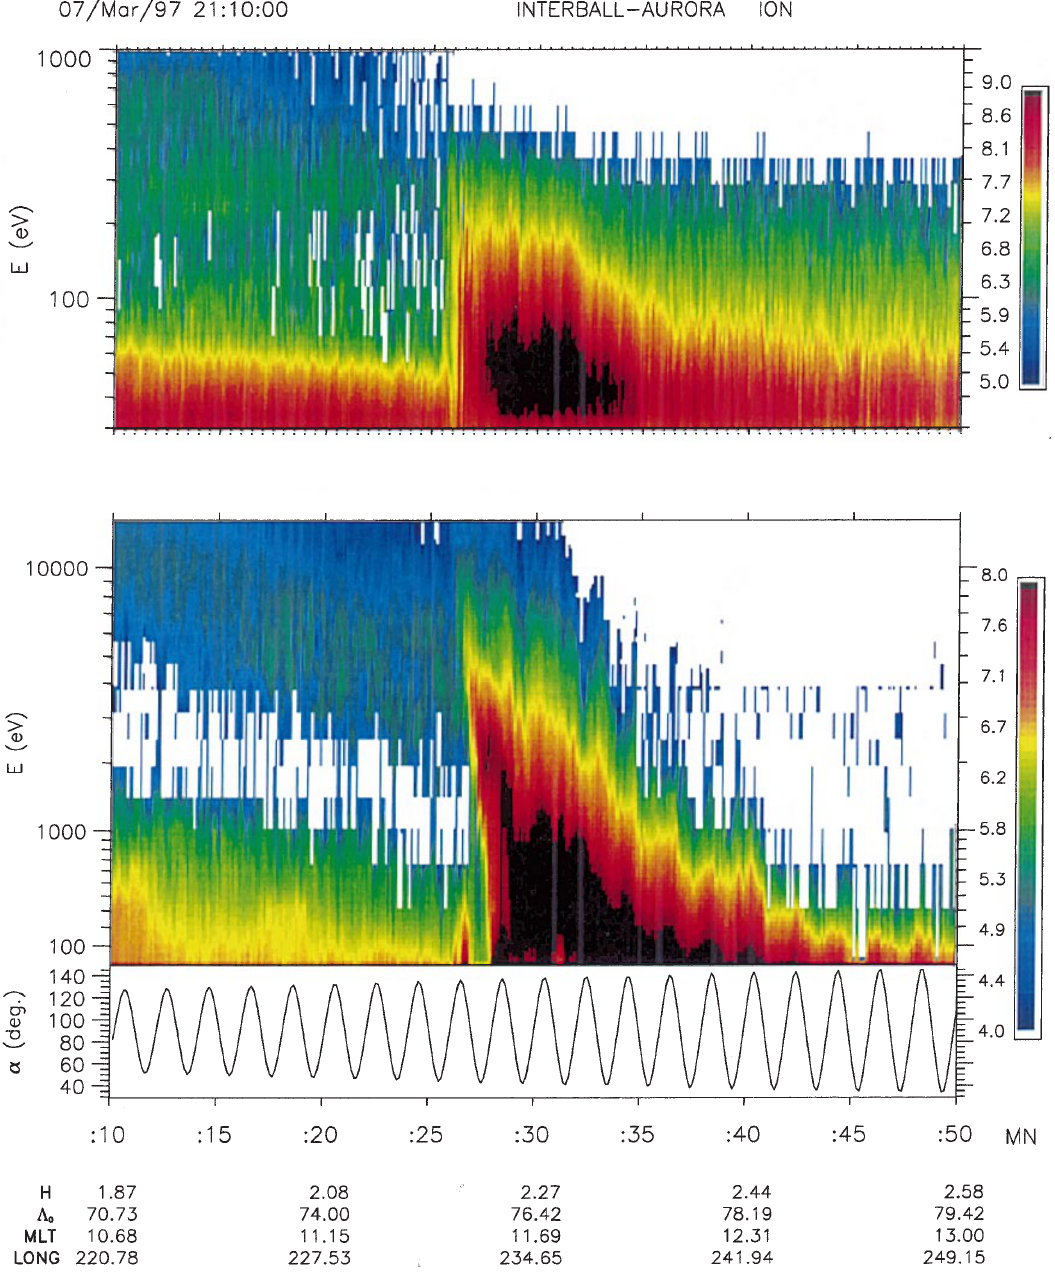
Fig. 6. Top panels: same as Fig. 5 for 24 February 1997 between 01:00 and 01:30 UT. The third panel from the top gives the oxygen fluxes and the bottom panel is the pitch-angle variation of both hydrogen and oxygen ions